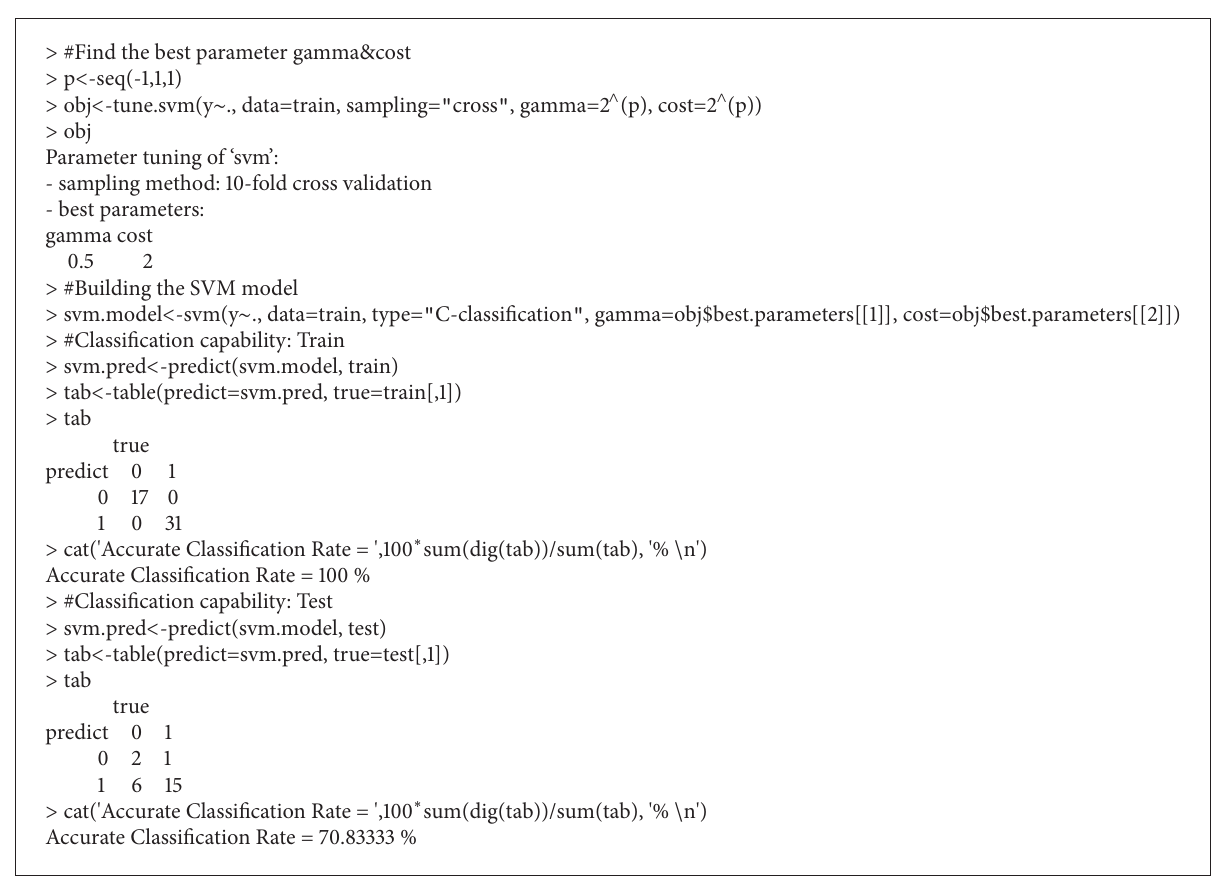
Algorithm 1: The SVM modeling output.